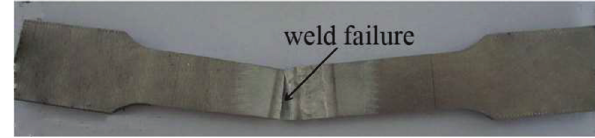
Figure 9: Global view of butt joint fractured.